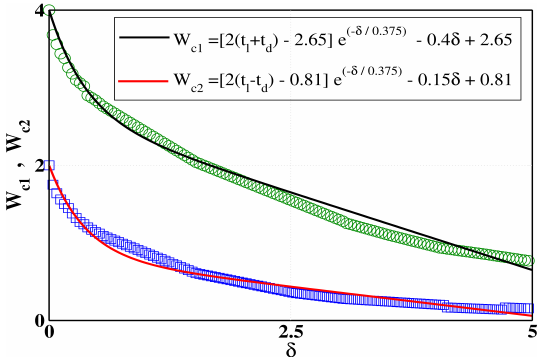
Figure 5. (Color online). Dependence of two critical points W c 1 and W c 2 on the interaction parameter δ for the BT-I ladder. The green circles and blue squares, associated with the chain-1 and chain-2, are numerically computed, and these data points are fitted with appropriate mathematical expressions which are given in the inset. The two expressions give a very good fit of the numerical data.